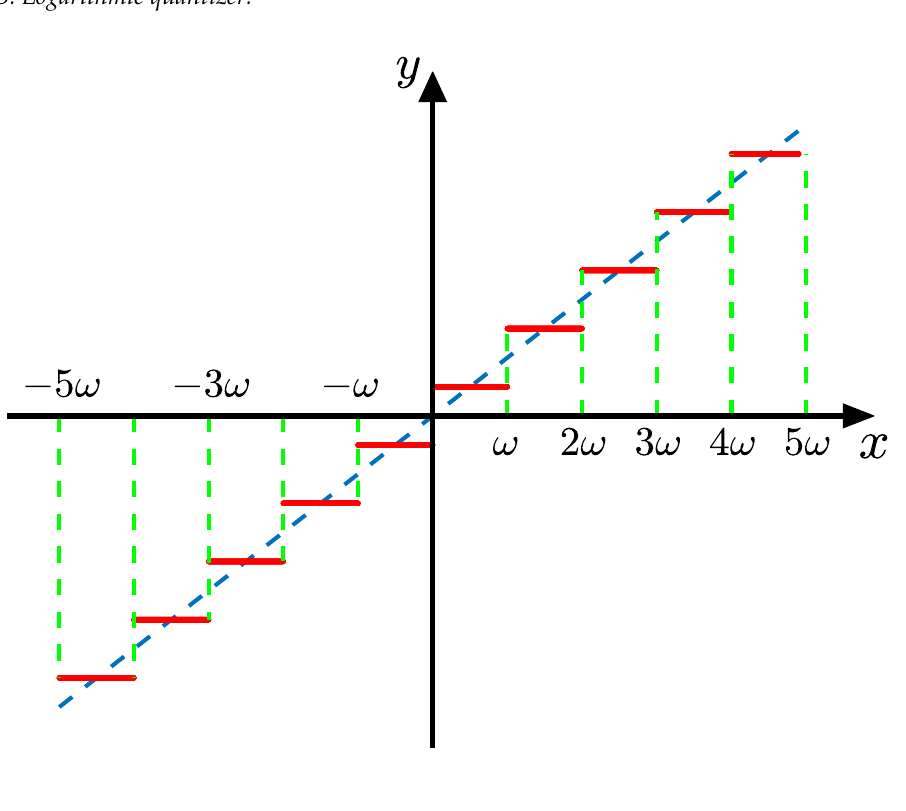
Figure 2. Diagram of the uniform